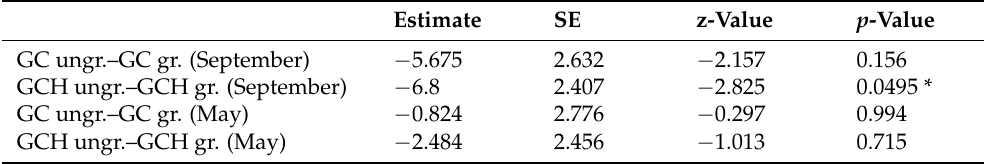
Table A18. Differences in activity densities of eurytopic carabid beetles, comparing the grazed pastures and ungrazed strips of the grass–clover (GC) and the grass–clover herbs (GCH) in May/June and September. p -values are indicated as * p <